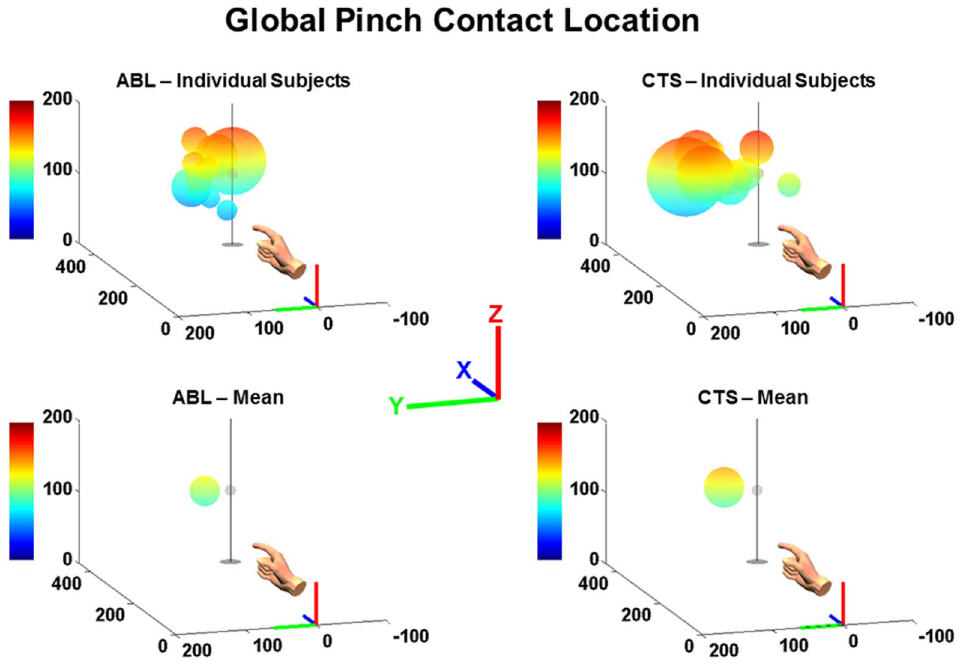
Figure 7. Mean pinch contact location for individual ABL and CTS subjects relative to virtual target, pictured with stand. Sphere center denotes mean pinch contact location and radius denotes pinch precision (1 s.d.) about that location. Pinch contact spheres shown relative to pinch target silhouette with respect to global coordinate system (X = + forward, Y = + left, Z = + up). Note: Color bar denotes height and transparency overlay indicates perceptive depth for 3-D visualization.